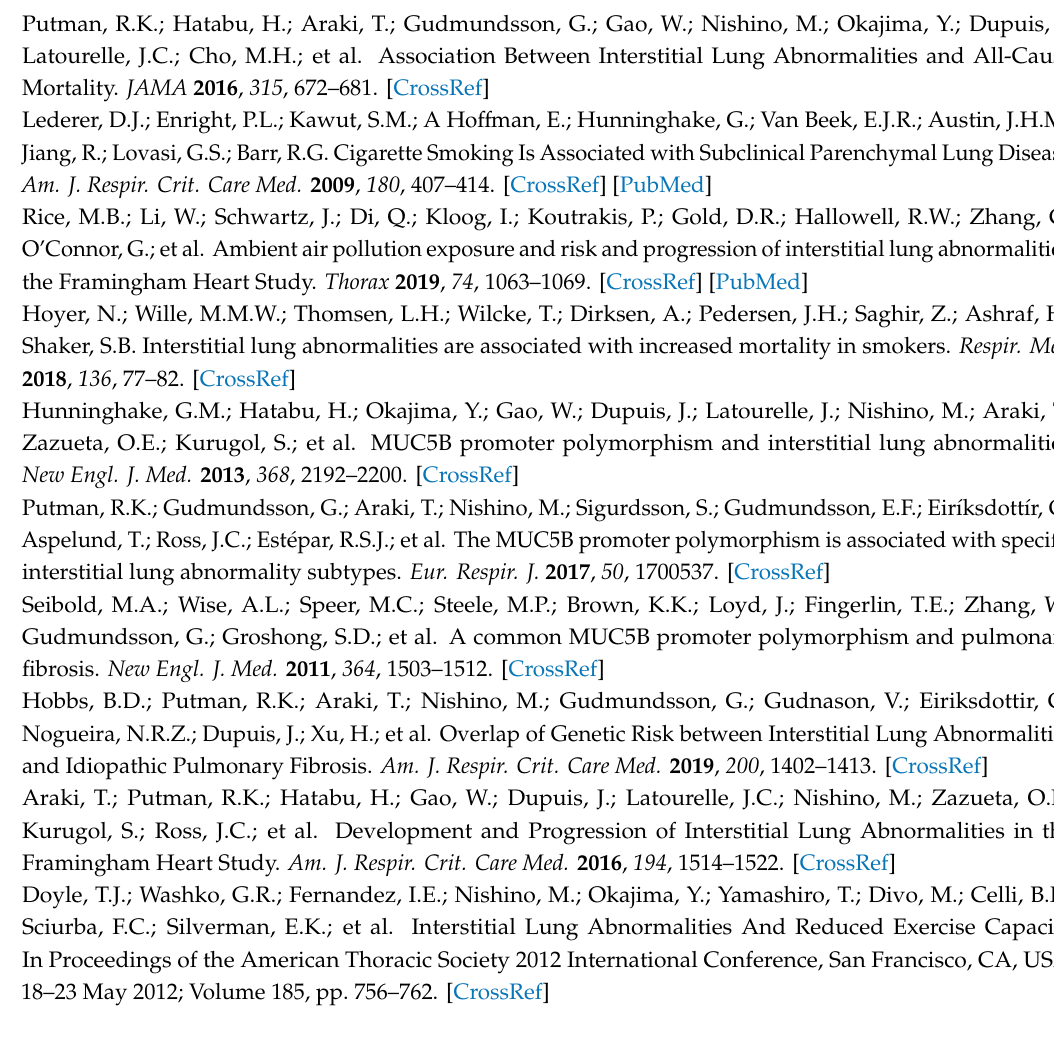
Table S4. Correlations between clinical parameters and candidate miRNAs in validation